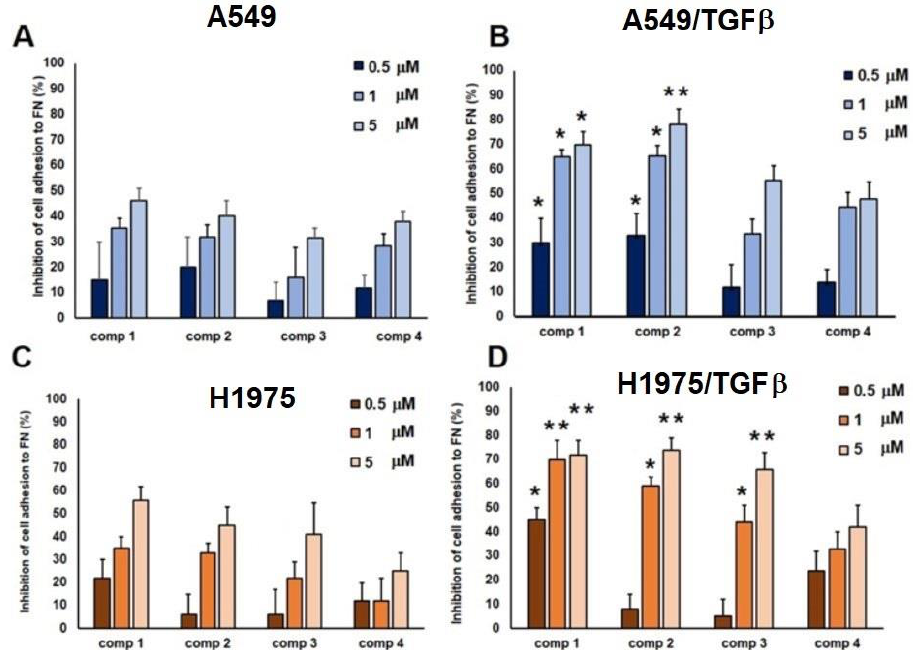
Figure 3. Inhibition of A549 ( A , B ) and H1975 ( C , D ) cell adhesion to FN (10 µ g/mL) in the presence of compounds 1 – 3 , or c (AmpLRGDL) 4 (2 h). Cells were grown in standard conditions ( A , C ) or were previously exposed to TGF β (10 ng/mL) for 48 h ( B , D ). The inhibitory activity was calculated as the percentage of cell adhesion to FN in untreated cells and was expressed as mean ± SEM. Experiments were carried out in triplicate. * p < 0.05 and ** p < 0.0002 vs equimolar concentrations of compound 4 , by one-way ANOVA followed by Tukey’s multiple comparison test.